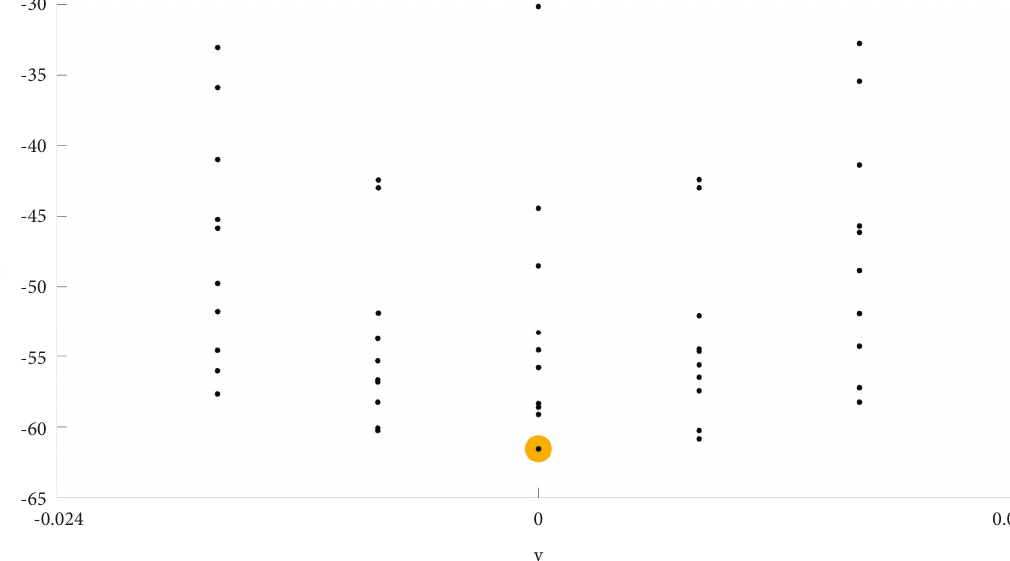
Figure 4: System (18). Eigenvalues of the Hessian at the points in 􏽥 X 0 close to the origin. Since both are negative, v must have a maximum at the critical point ( 0 , 0 ) .